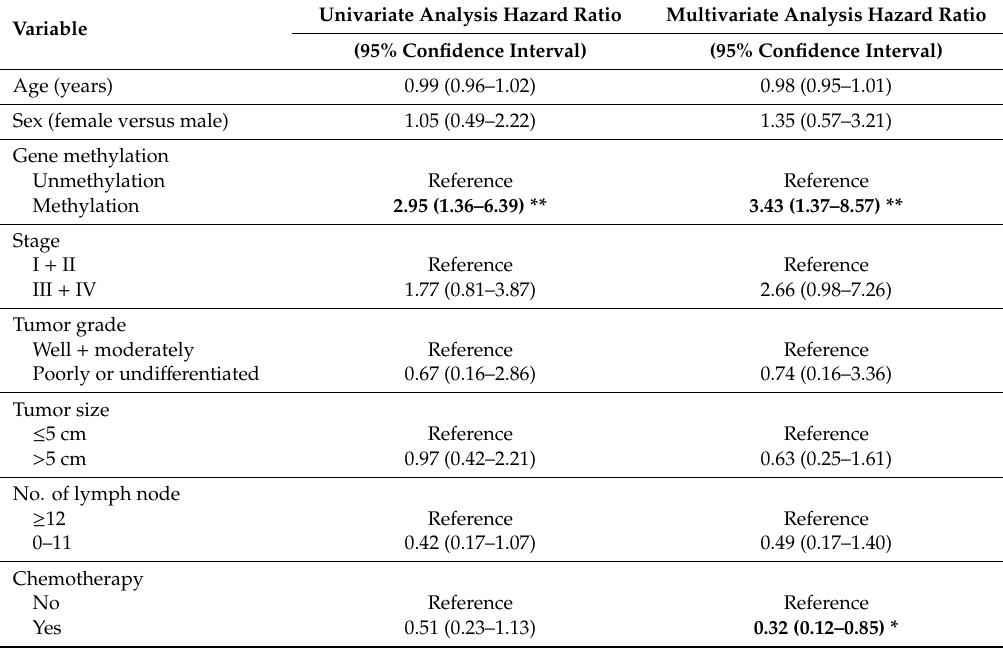
Table 4. Univariate and multivariate analysis of overall survival using clinical characteristics and the the four-gene methylation panel in 151 CRC